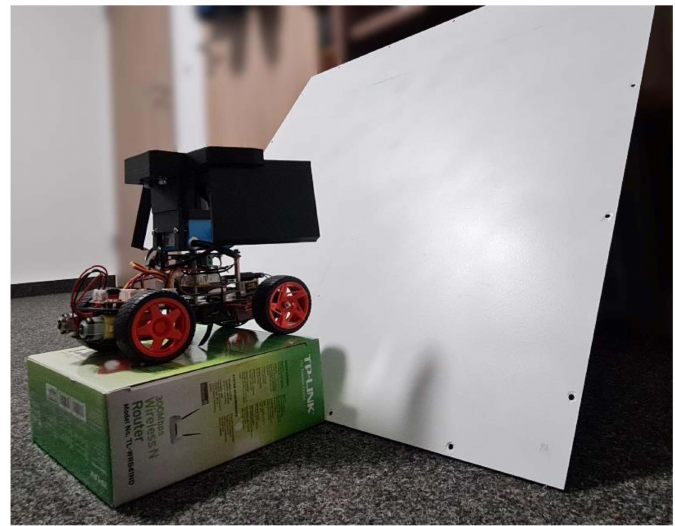
Figure 5. Photograph of the calibration setup. A white flat surface is positioned in front of the prototype vehicle. The position of the vehicle is elevated in order to have the Lidar sensor detect a larger part of the surface. The calibration surface is tilted around the x-axis for better calibration results. Note the 10 mm square piece of reflector foil that is attached near the center of the white surface and is necessary for the calibration procedure to succeed. (Background of room blurred for